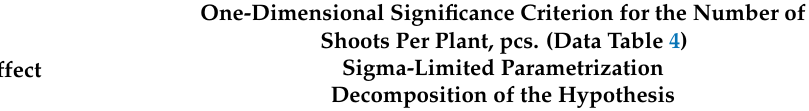
Table A3. Results of multivariate analysis of variance values of M. fragrans shoot multiplication coefficient in vitro